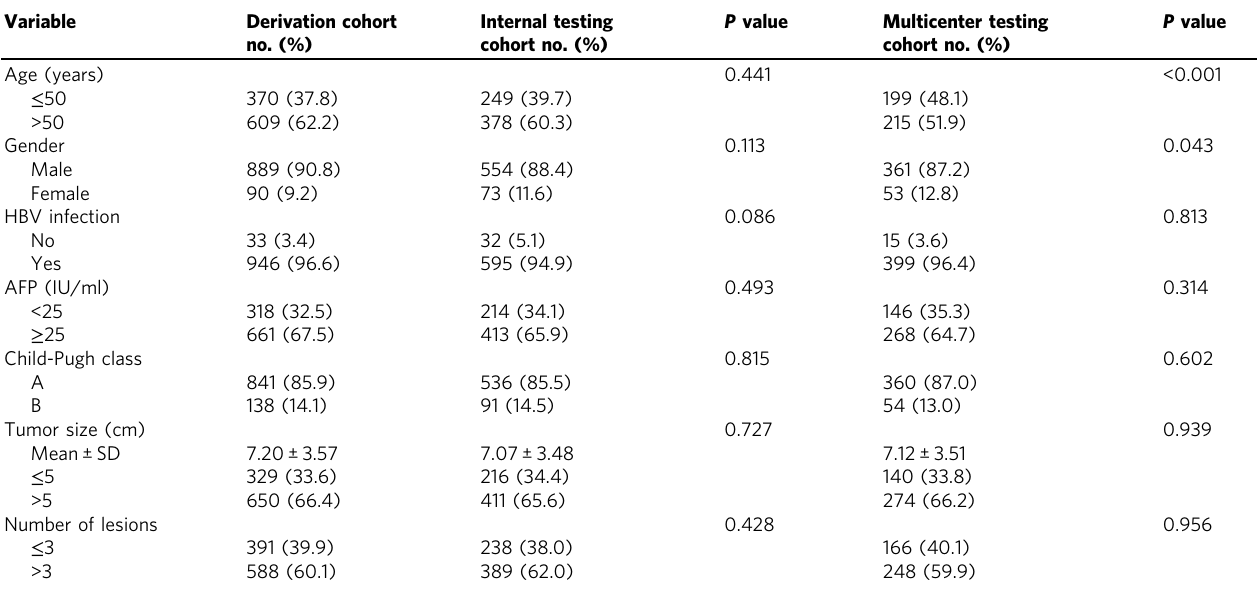
Table 1 Baseline characteristics of derivation, validation, and testing cohort at initial diagnosis Variable Derivation cohort no.